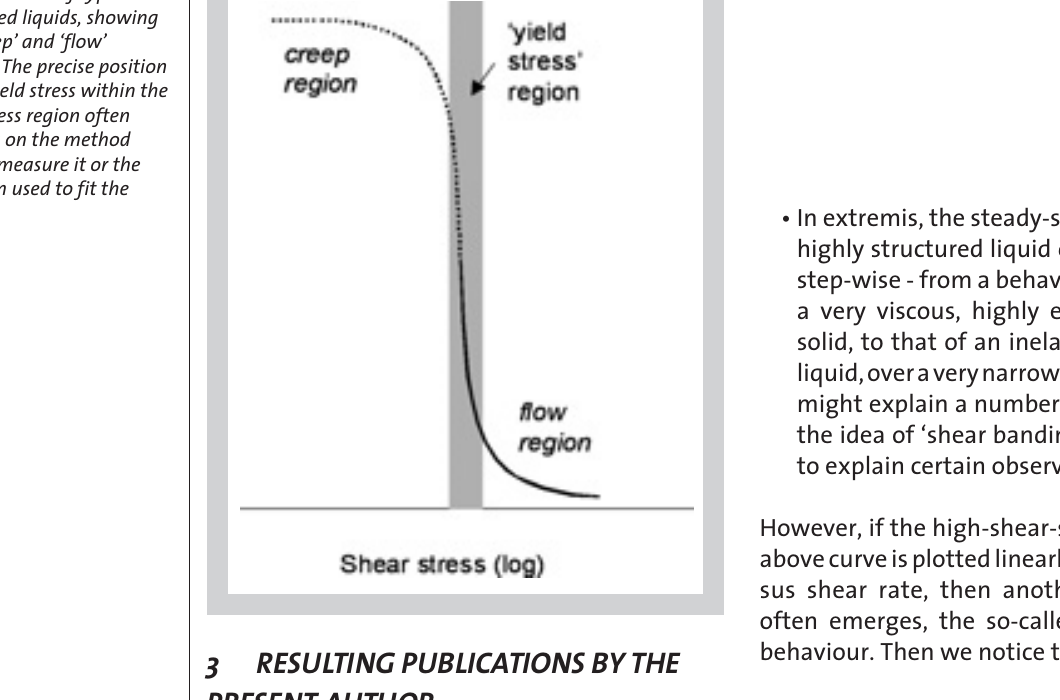
Figure 1: The flow curve of typical structured liquids, showing the ‘creep’ and ‘flow’ regions. The precise position of the yield stress within the yield stress region often depends on the method used to measure it or the equation used to fit the